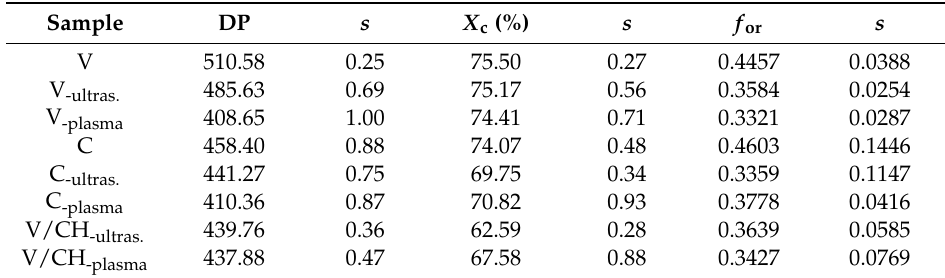
Table 2. Degree of polymerization (DP), crystallinity ( X c ), molecular orientation ( f or ) of fibers; s-presents the standard